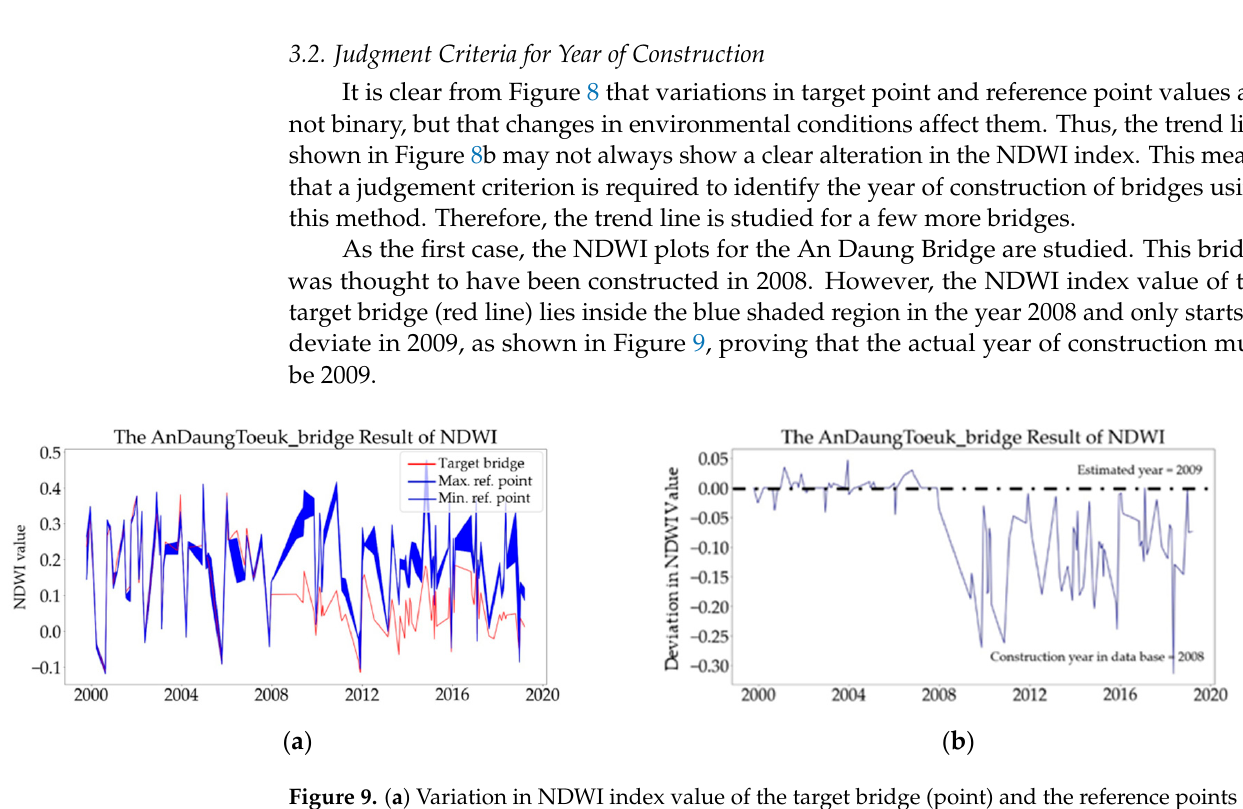
8 of 19 Figure 8. ( a ) Variation in NDWI index value at the target bridge (point) and reference points over